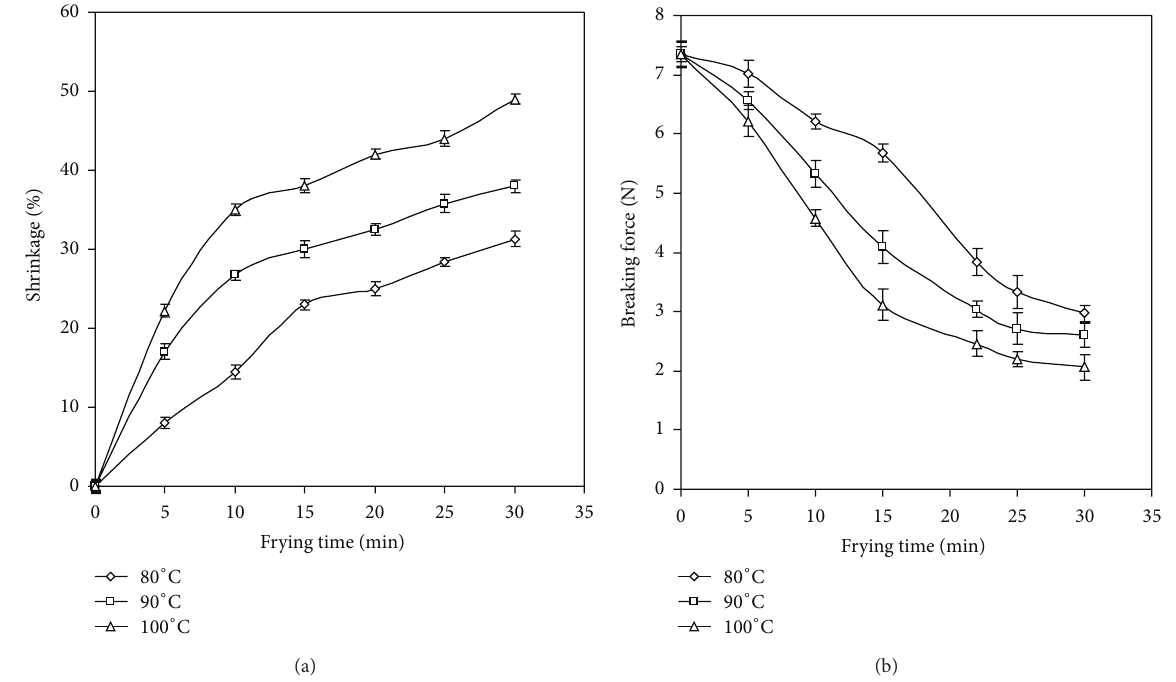
Figure 3: (a) Shrinkage in jackfruit chips during frying; (b) texture of jackfruit chips during frying.